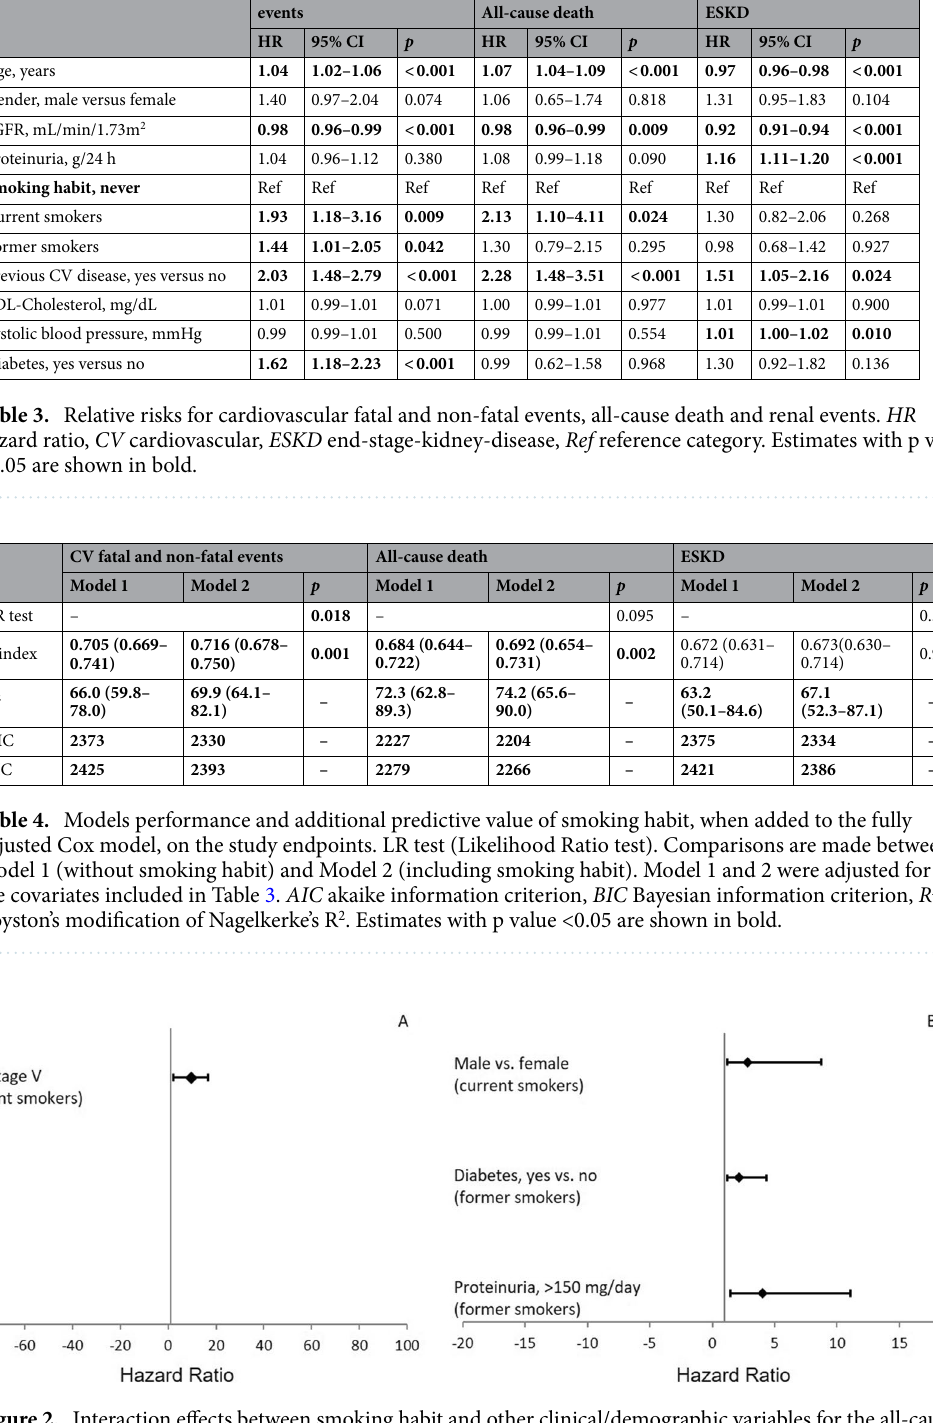
Figure 2. Interaction effects between smoking habit and other clinical/demographic variables for the all-cause death ( A ) and renal ( B )